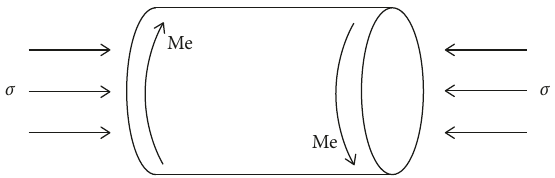
Figure 1: Schematic diagram of test method.